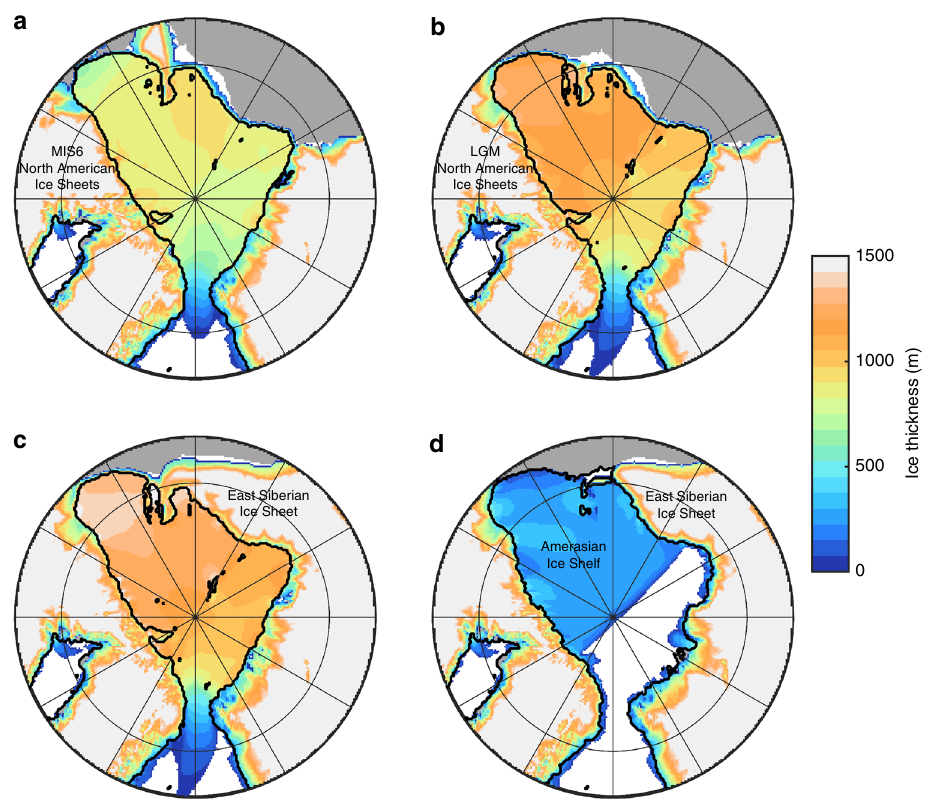
Fig. 3 Ice shelf experiments showing simulated ice thickness. a Climate forcing with reduced Laurentide Ice Sheet extent 20 . b Climate forcing with LGM equivalent Laurentide Ice Sheet. c With terrestrial ice sheet able to form in Eastern Siberia. d Ice shelf prevented from expanding into the Eurasian Basin. Black line shows the grounding line. Model domain extends to 40 ˚ N but is cropped in these fi gures. a – d Mean shelf thicknesses within the Arctic Basin are 833, 1070, 1173, and 254 m and fl oating ice volumes are 3.54, 4.42, 4.76, and 0.79 × 10 6 km